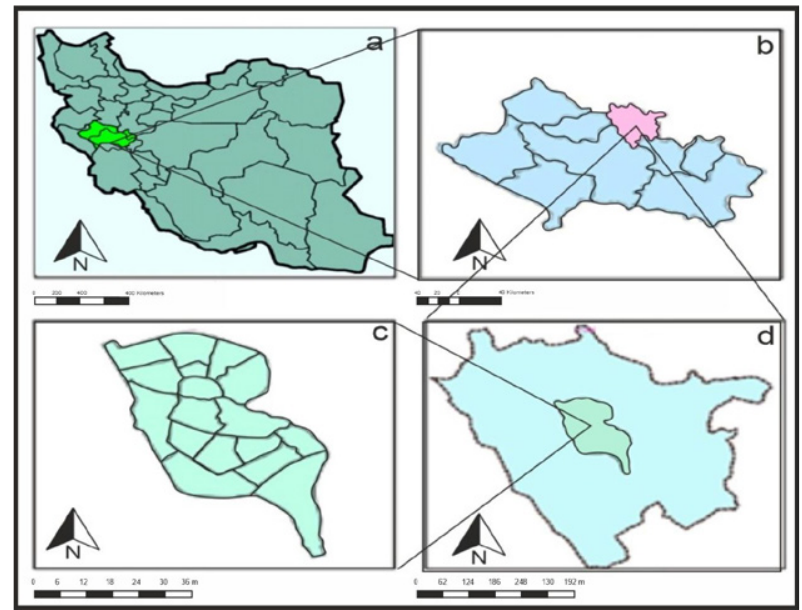
Fig.2: The position of Boroujerd city in political-functional divisions upstream a) The position of Lorestan province in Iran. b) The position of Borujerd city in Lorestan province. c) The position of the primary care in Borujerd. d) The position of neighborhood primary care in Borujerd)